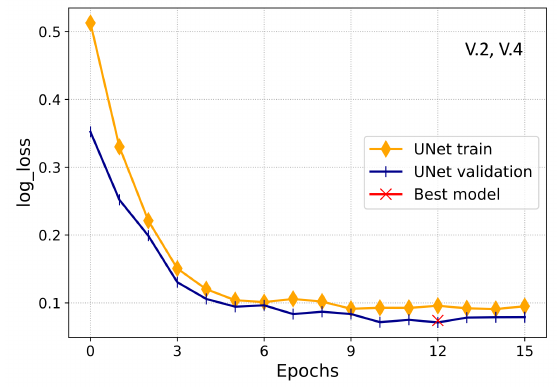
Figure 14. UNet-based convergence analysis during training.